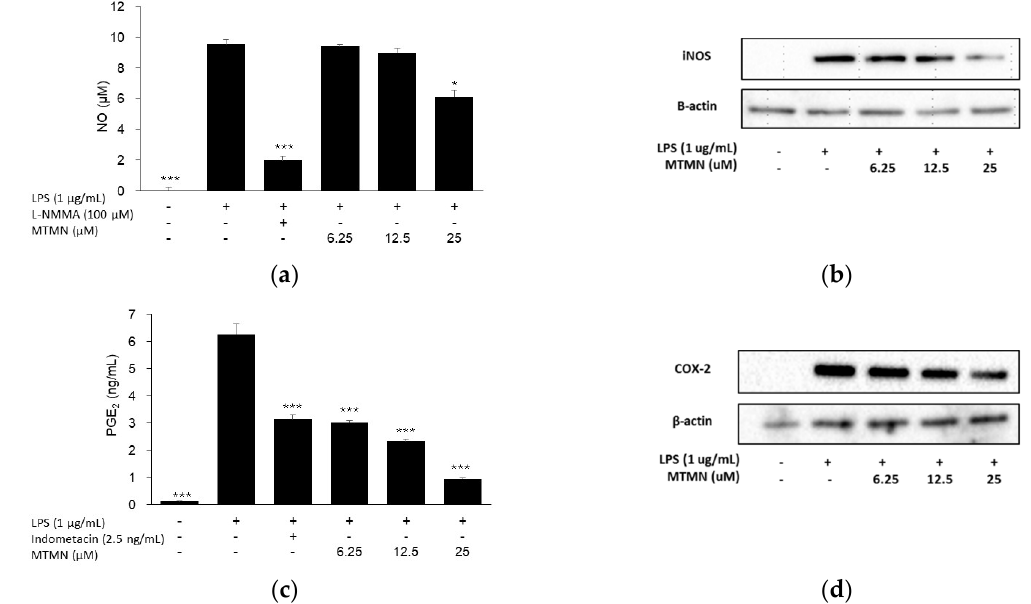
Figure 2. Effect of (7 S ,8 S )-Δ 8′ -3,4-methylenedioxy-3′,5,5′-trimethoxy-7-monoacetate-8. O .4′-neolignan (MTMN) on the production of nitric oxide (NO) ( a ) and prostaglandin E 2 (PGE2) ( c ), the expression of nitric oxide synthase (iNOS) ( b ) and cyclooxygenase-2 (COX-2) ( d ) in lipopolysaccharide (LPS)-stimulated RAW264.7 murine macrophage cell line. Data are presented as the mean ± SEM. * p < 0.05 and *** p < 0.001 are compared with the LPS only treated group.